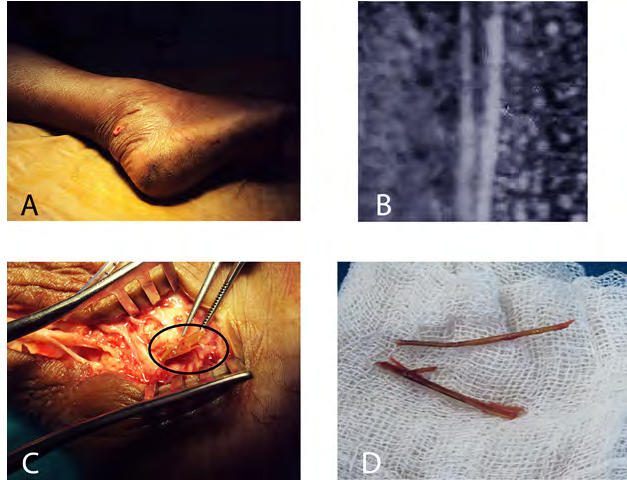
bodies.Fig 3 : A. A 46 years old female with a discharging sinus at posterolateral ankle; B. Ultrasonogram revealing